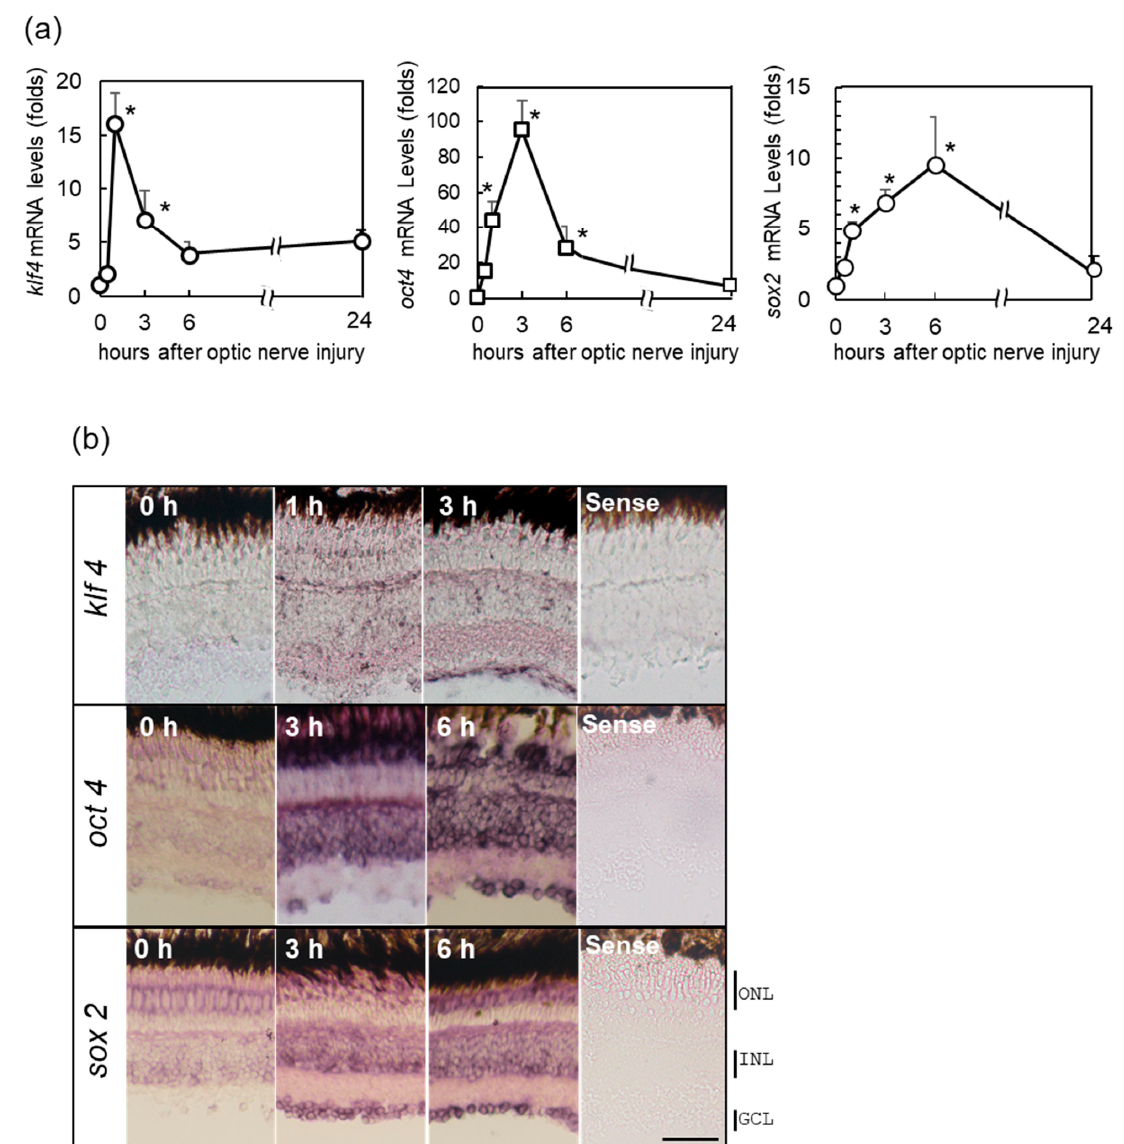
Figure 2. Upregulation of the Yamanaka factors (OSK) in zebrafish retina after ONI. ( a ) mRNA expression levels of OSK after ONI were determined by quantitative real-time PCR (left, klf4; center, oct4; right, sox2). ( b ) In situ hybridization of OSK in zebrafish retina after ONI. Klf4 mRNA expression started to increase at 1 h and localized to the GCLs at 3 h after ONI. Oct4 mRNA signal was observed in the GCL and strongly in the INL and ONL at 3 h, but this strong signal was seen in all nuclear layers at 6 h after ONI. Sox2 mRNA expression was observed in all nuclear layers 3 h after ONI and more prominent at 6 h. No positive signals could be seen with the sense probe (Sense). Five to six experiments were repeated with different retinas under each experimental condition and produced the same results. Data are expressed as the mean ± SEM and analyzed by one-way ANOVA, followed by Scheffe’s multiple comparisons. Statistical significance was set at * p < 0.05. Scale bar = 50 µ